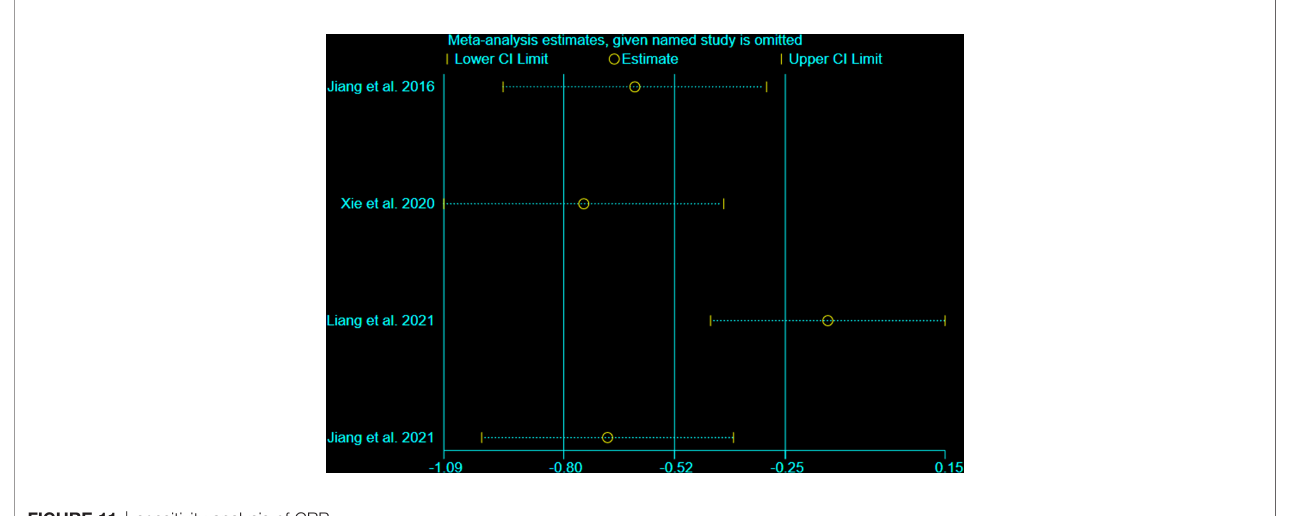
FIGURE 11 | sensitivity analysis of CRP.